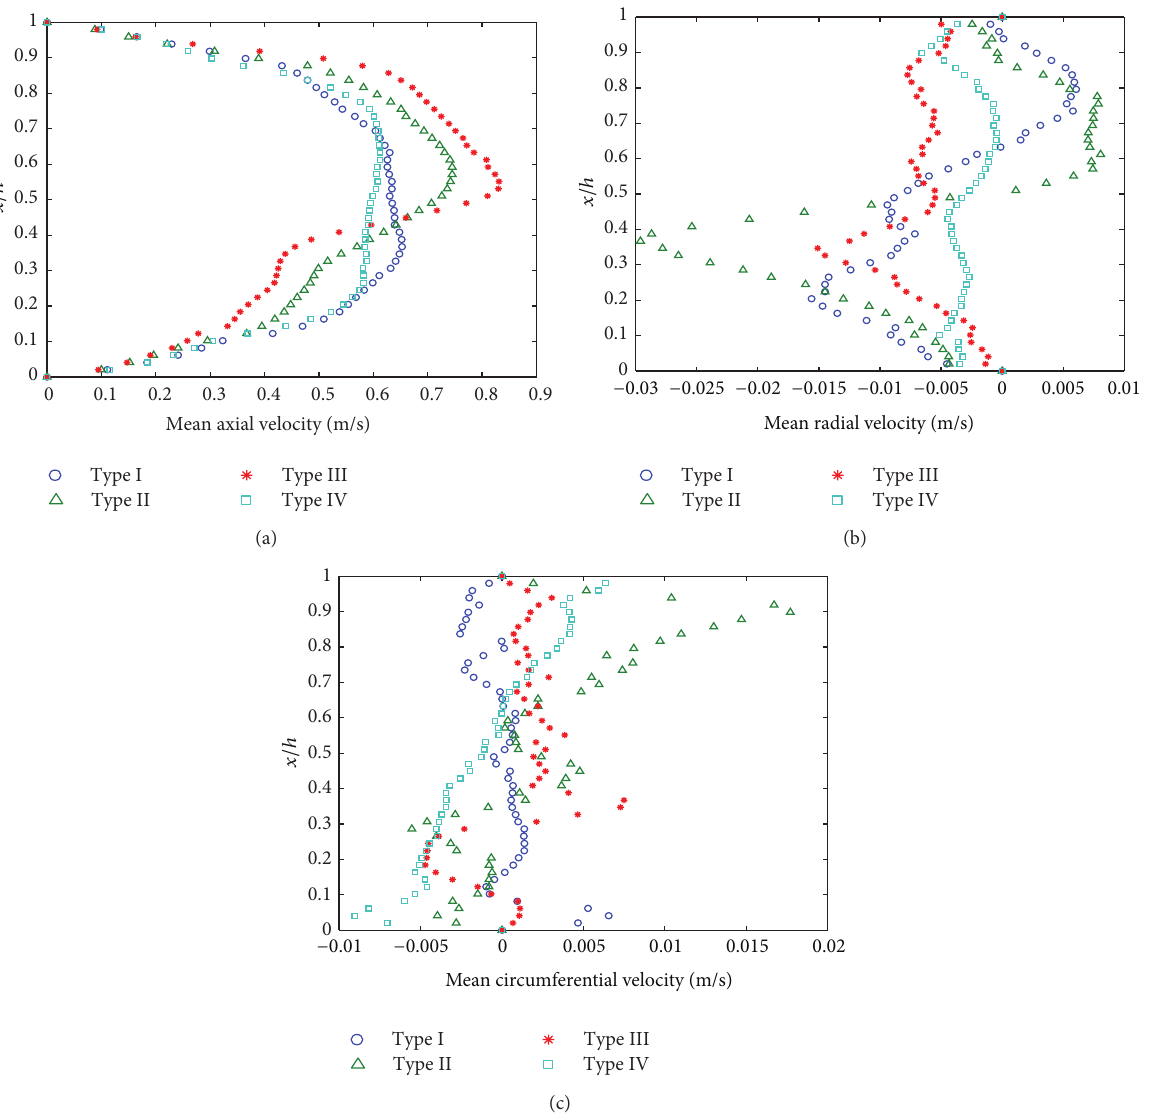
Figure 8: Mean velocity profiles averaged in 𝑦 - 𝑧 plane plotted against wall-normal distance scaled by lumen height ( ℎ ) during peak systole ( 𝑄 max ) for (a) axial mean velocity, (b) radial mean velocity, and (c) circumferential mean velocity.